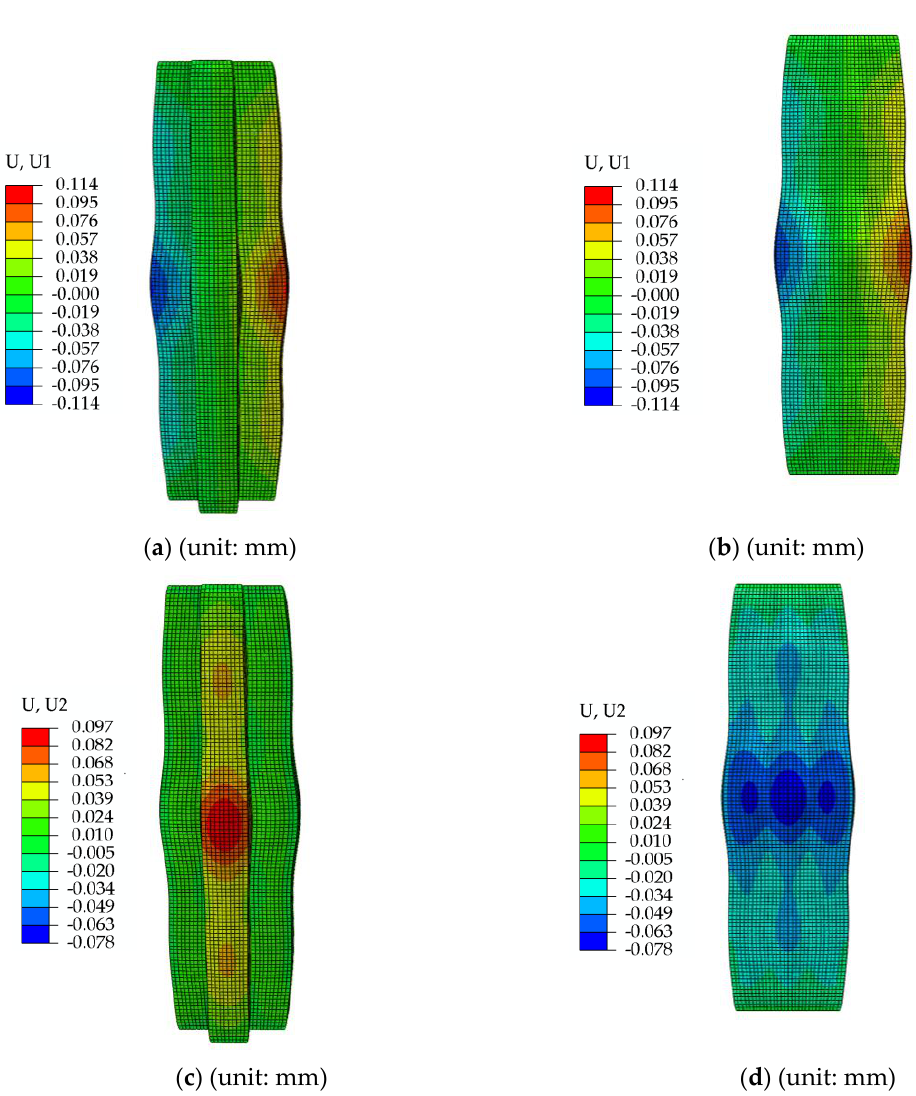
Figure 11. Deformation diagram of the finite element model. ( a ) Front view in the transverse direction, ( b ) back view in the transverse direction, ( c ) front view in the longitudinal direction, and ( d ) back view in the longitudinal direction.